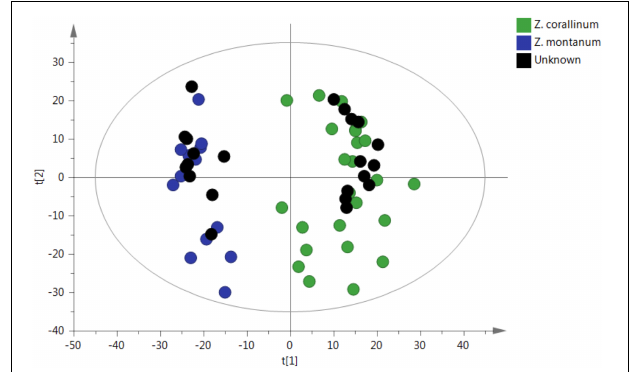
FIGURE 6 | PCA prediction of unknown samples from GC-MS. The black circle represents the unknown sample. [The x-axis and y-axis, respectively, represented the correlation coefficient between the variance and the first two principle components (t1 and